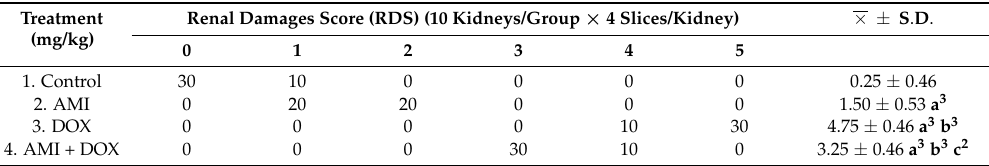
Table 5. The effects of different treatments on the degree of renal alterations 28 days after receiving last treatment. Treatment